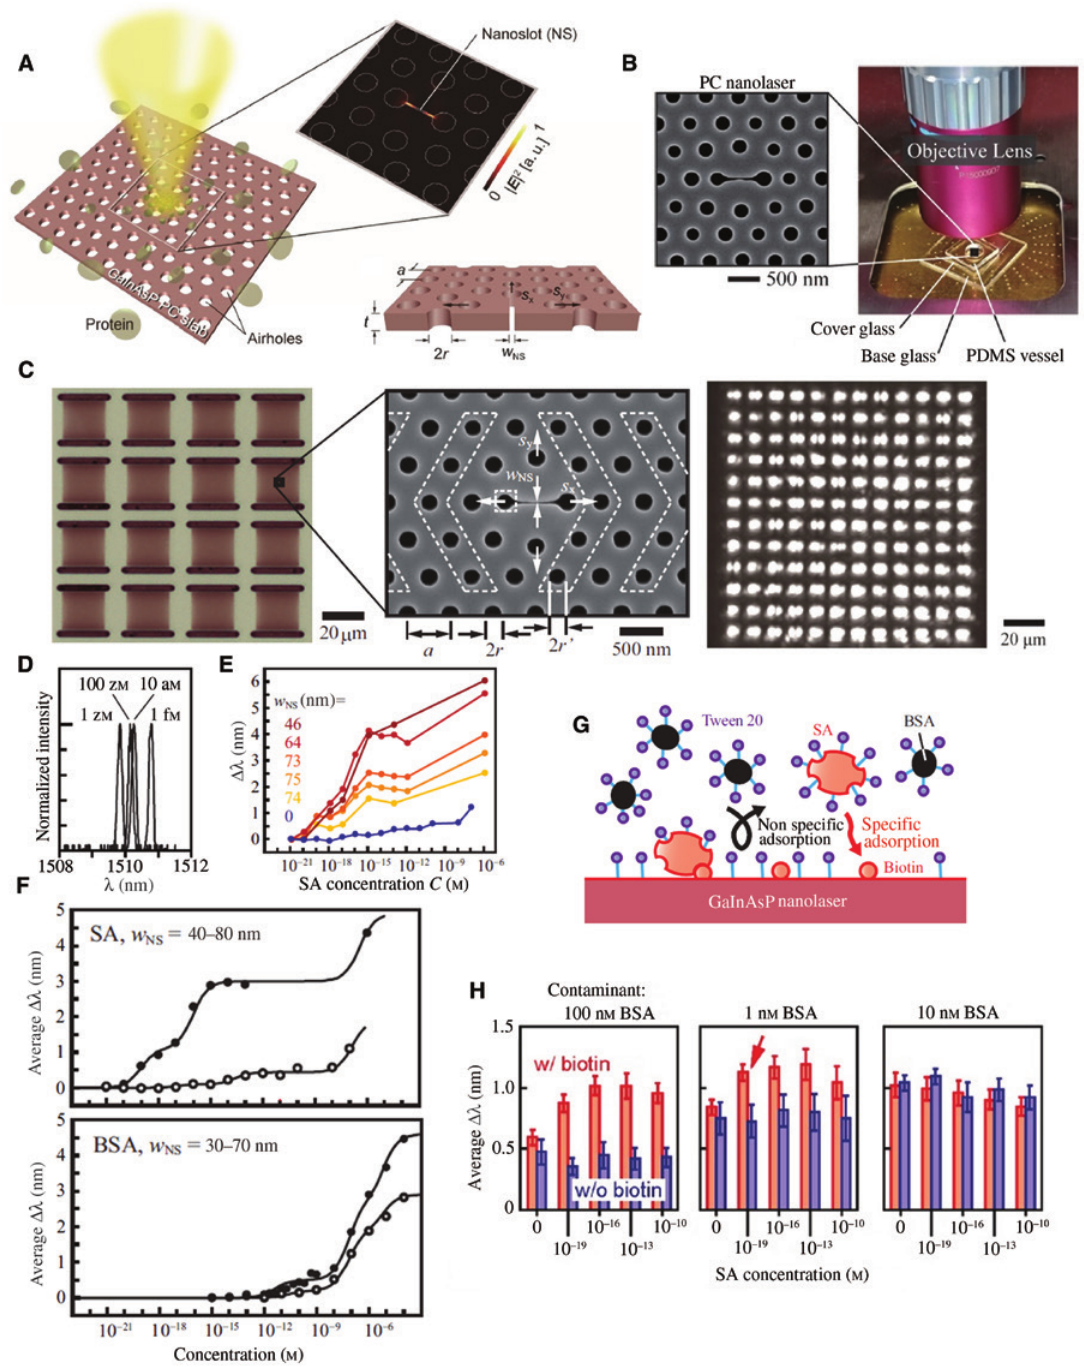
Figure 26: Nanoslot nanolasers in PhCs. (A) Nanoslotted PhC nanolaser with adsorbing biomolecules, shown alongside a computed modal energy distribution (above) and cross- sectional schematic of the device (below). Adapted from [163]. (B) Experimental configuration, including an SEM image of a PhC sample, and (C) an array of nanoslotted GaInAsP PhC nanolasers for biosensing (i.e. optical micrograph to the left, SEM image of a subsection with modi- fied side hole diameters in the centre, and near-field pattern of the 144-nanolaser array to the right). Adapted from [164, 166, 167]. (D) Laser spectra at different SA concentrations and (E) wavelength shift Δλ versus SA concentration for six devices with varying nanoslot widths W . (F) Average wavelength shift for devices with (closed circles) and without (open circles) a nanoslot. Adapted from [163] and [164]. (G) NS Pictorial representation of specific biotin-SA binding, in a BSA-contaminated environment, onto the nanoslotted PhC nanolaser biosensor. (H) Biosensing of SA protein in samples with BSA contaminant wherein the contaminant concentration increases from left to right. The error bars show a 95% confidence interval where the largest selectivity is indicated by the red arrow. Adapted from